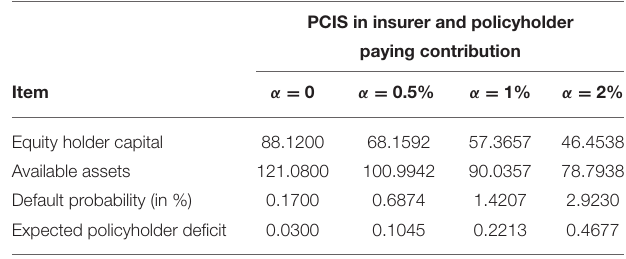
TABLE 7 | Fair capital of equity holder E * 0 for different contribution rates α in policyholder and insurer paying contributions.